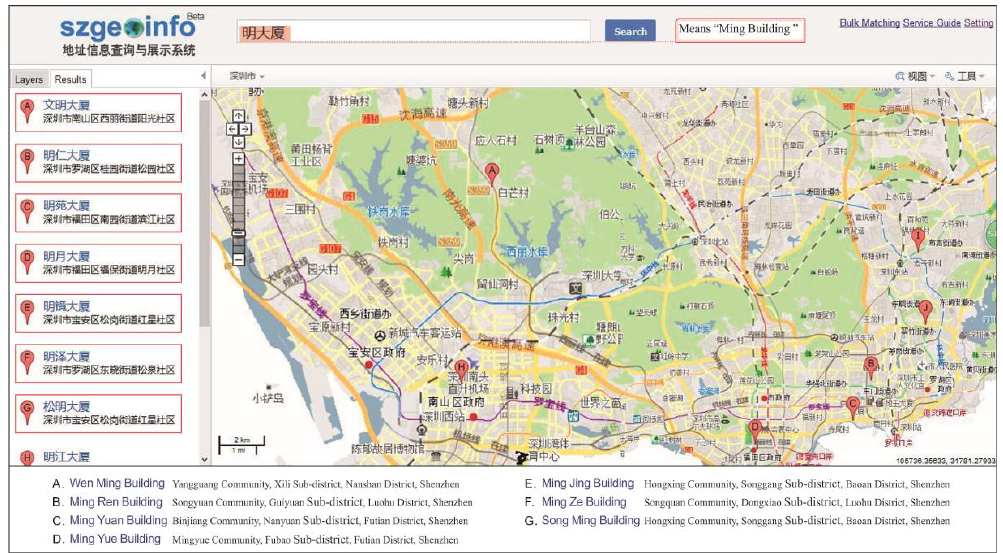
Figure 11. The online geocoding display system (fuzzy matching).